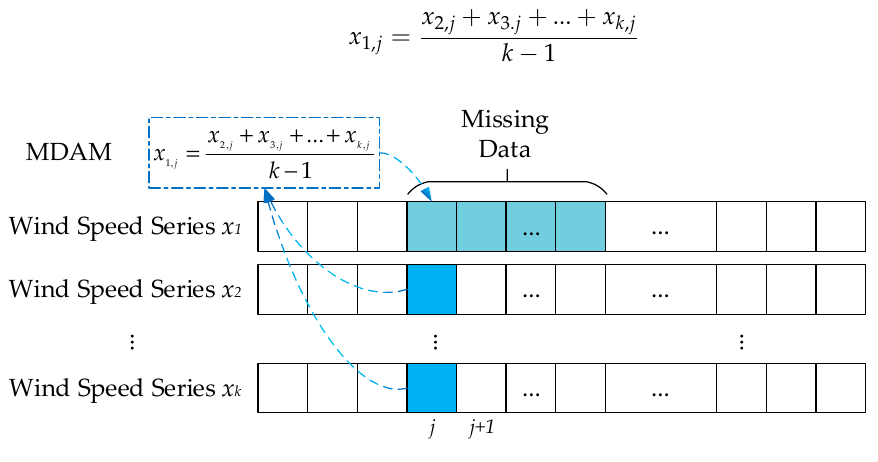
Figure 1. Schematic diagram of MDAM.